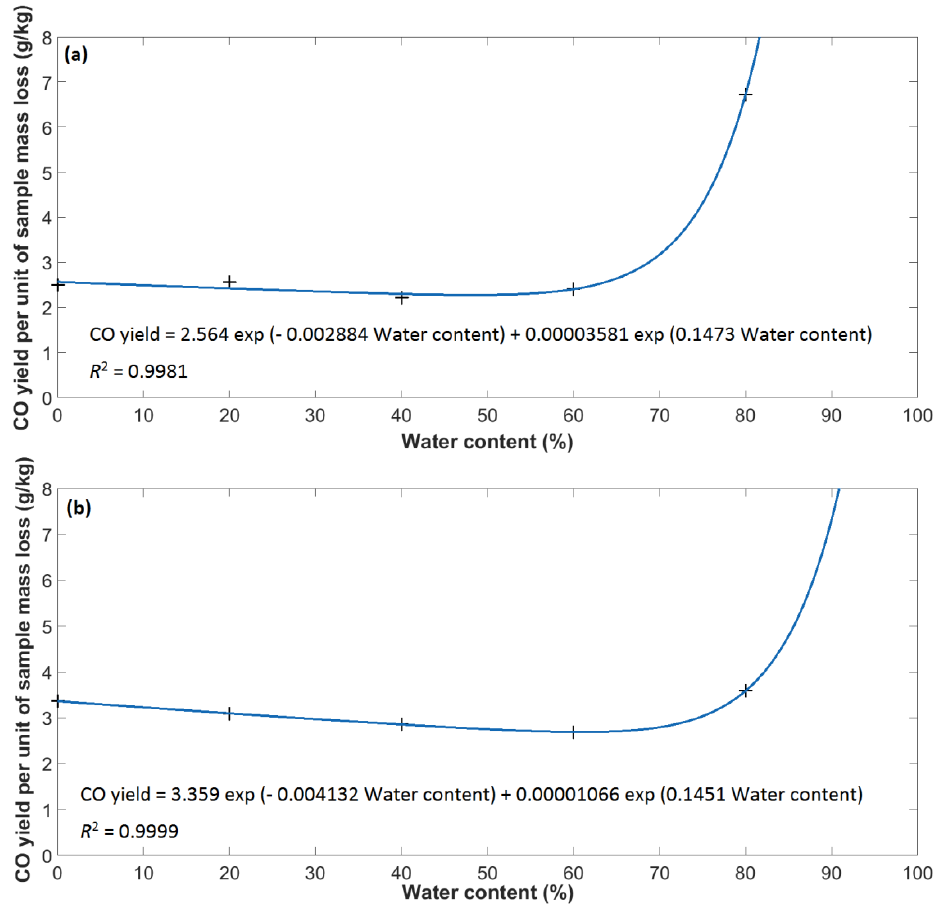
Figure 7. Dependency of the carbon monoxide (CO) yields (per mass loss) of investigated fuels on the water content: ( a ) Dependency of the CO yields (per mass loss) of methanol on the water content; ( b ) Dependency of the CO yields (per mass loss) of ethanol on the water content.